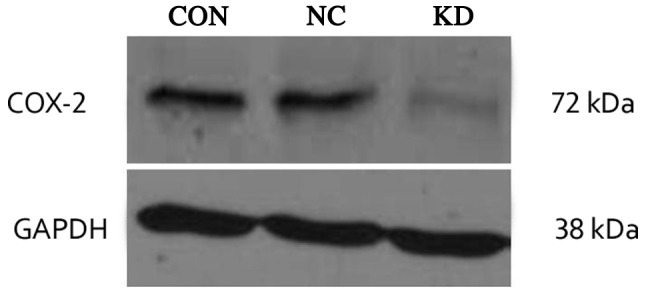
Western blot analysis of Cyclooxygenase-2 protein expression. COX, cyclooxygenase; kDa, kilodaltons; CON, control; NC, negative control; KD, interference group.